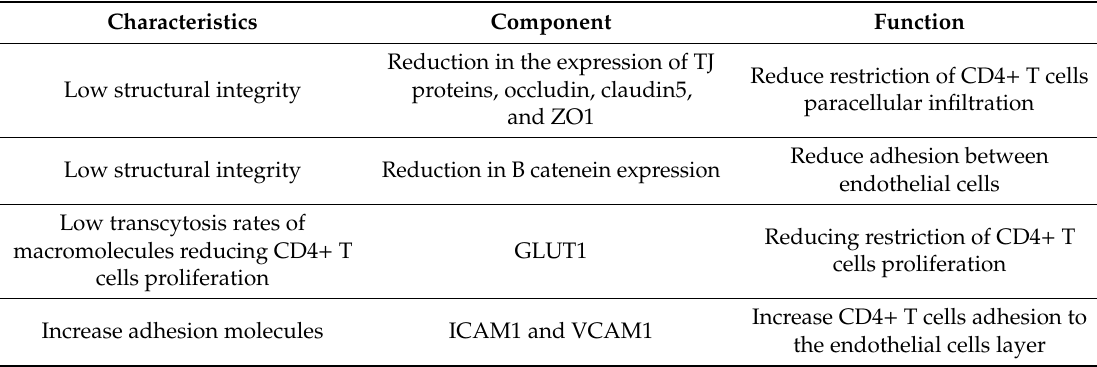
Table 5. The e ff ect of endothelial cells characteristics on CD4 + T cells migration in